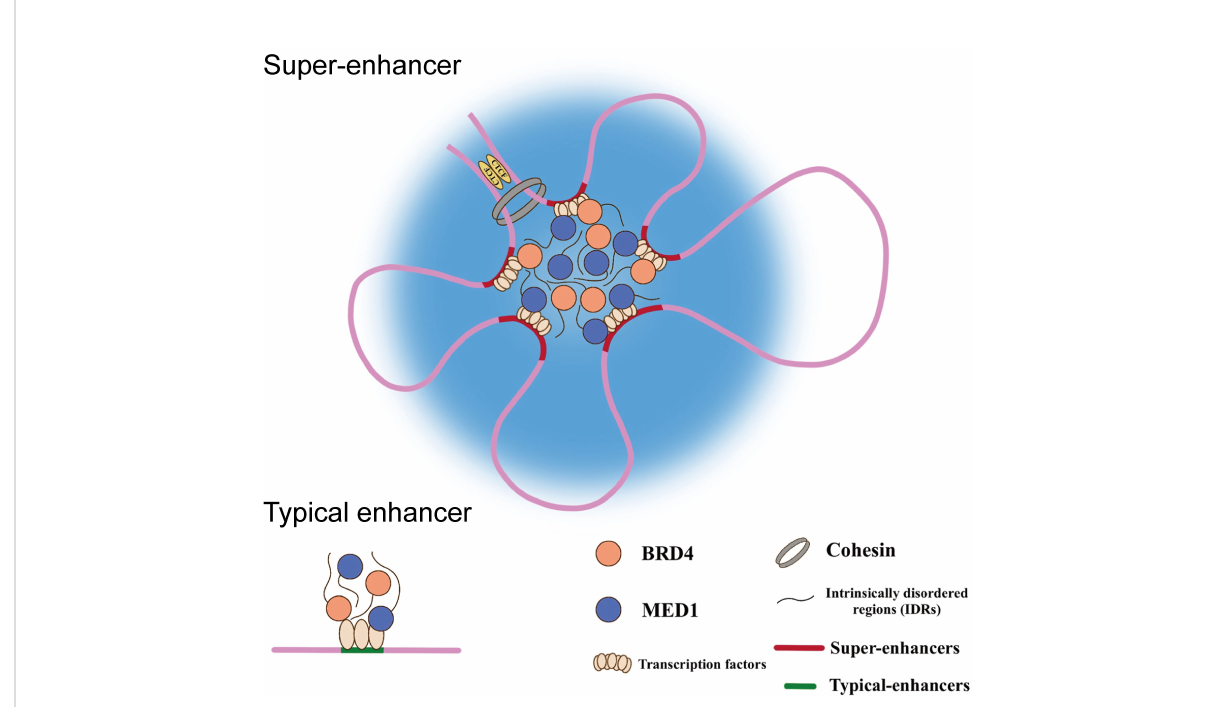
FIGURE 1 Schematic diagram of the phase-separated condensates at